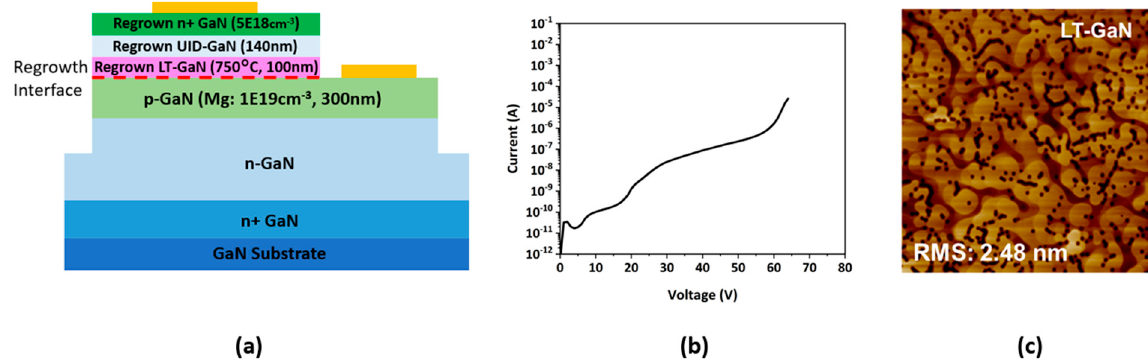
Figure 6. Characteristics of the MOCVD regrown LT-GaN at 750 °C. ( a ) The schematic of isolated regrown p-n test structure. ( b ) Reverse leakage current measured from the test structure in ( a ). ( c ) AFM image of the regrown LT-GaN at 750 °C.